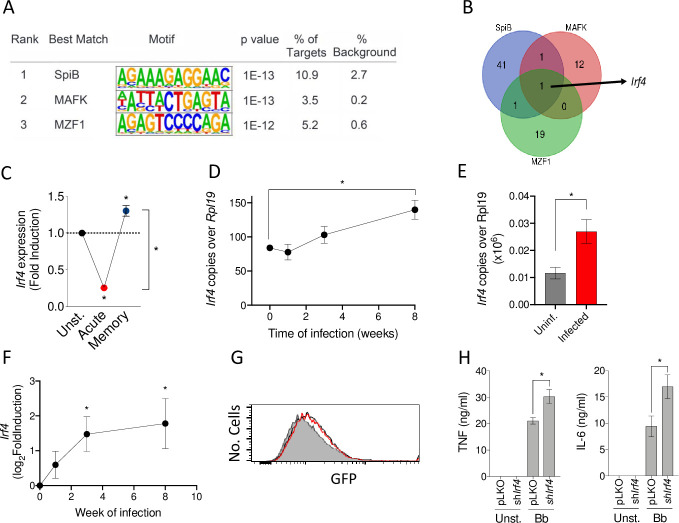
B. burgdorferi–induced Irf4 expression modulates the induction of pro-inflammatory cytokines in previously experienced macrophages.(A) Motifs associated with the expression of genes specifically up-regulated in memory macrophages compared to acutely stimulated cells. (B) Venn diagram showing the genes that are co- or differentially regulated by the transcription factors, SpiB, MAFK, and MZF1. The only gene regulated by the 3 transcription factors is Irf4. (C) Irf4 gene expression in acute, memory, and non-stimulated macrophages determined by real-time PCR relative to Rpl19. The results represent 4 independent mice. *, Student t test, p < 0.05. (D) Expression levels of Irf4 in peripheral blood of infected mice over time, as determined by real-time PCR relative to Rpl19. Groups of 3–6 mice were employed for each time point. *, Student t test, p < 0.05. (E) Irf4 expression of 21-day-infected hearts vs. uninfected controls by real-time PCR relative to Rpl19. (F) Log2 fold induction of Irf4 in infected hearts at different time points of infection. Groups of 3–6 mice were employed for each time point. *, Student t test, p < 0.05. (G) Phagocytosis by BMMs infected with lentivirus containing shIrf4 (red histogram) or the control vector, pLKO (black histogram). The gray histogram represents a 4°C control. The cells were coinfected with lentivirus containing 2 different shRNA sequences (TRCN0000081548; TRCN0000081549). The average level of silencing of the Irf4 was calculated to be at 23 ± 0.05%. (H) TNF and IL-6 induction by B. burgdorferi in Irf4-silenced and control BMMs. The cells were stimulated for 20 hours, followed by the measurement of the cytokines in the supernatants by ELISA. The data underlying the graphs in Fig 4 can be found in S4 Data, GSE125503, and GSE152168. BMM, bone marrow-derived macrophage; GFP, green fluorescent protein; IL, interleukin; PCR, polymerase chain reaction; shRNA, short hairpin RNA; TNF, tumor necrosis factor.